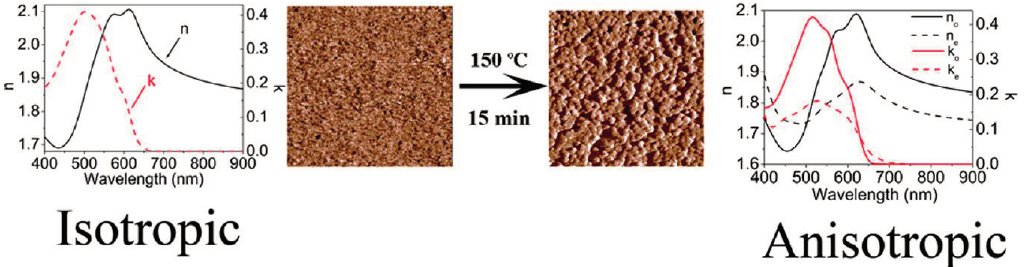
Figure 15. Obtained n and k values for perpendicular and parallel polarizations, respectively. Cited from [119]. Copyright 2013, America Chemistry